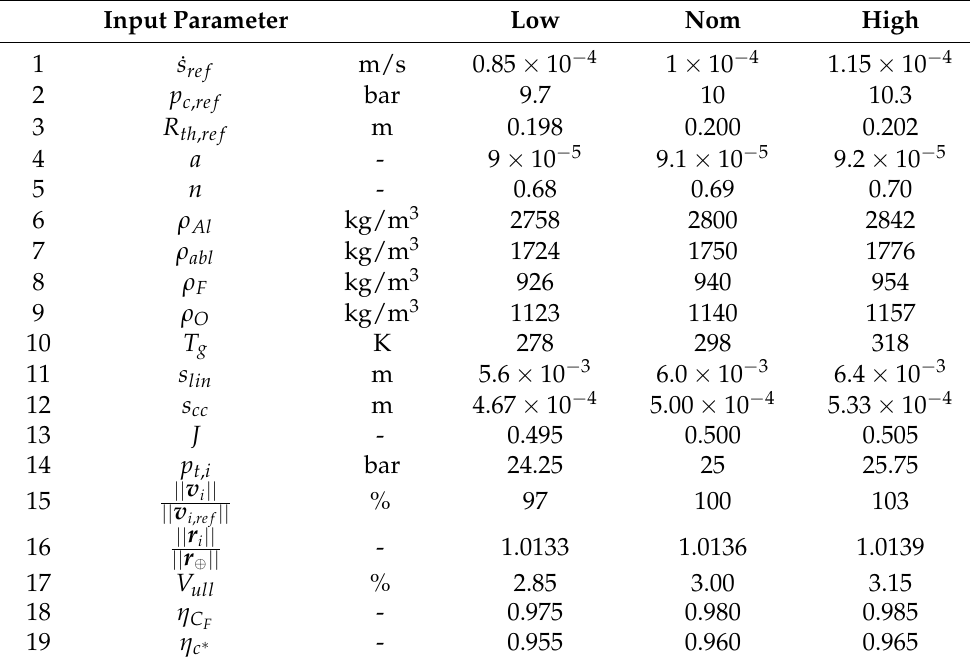
Table A2. Input parameters: nominal and off nominal